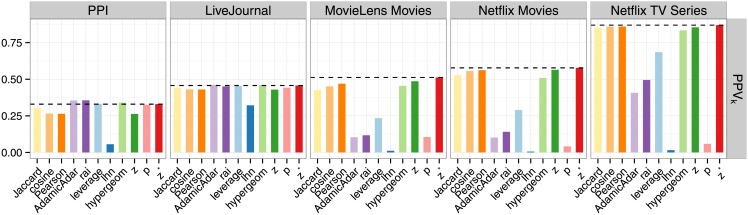
Performance of the different similarity measures in the LLAP as quantified by the PPVk.